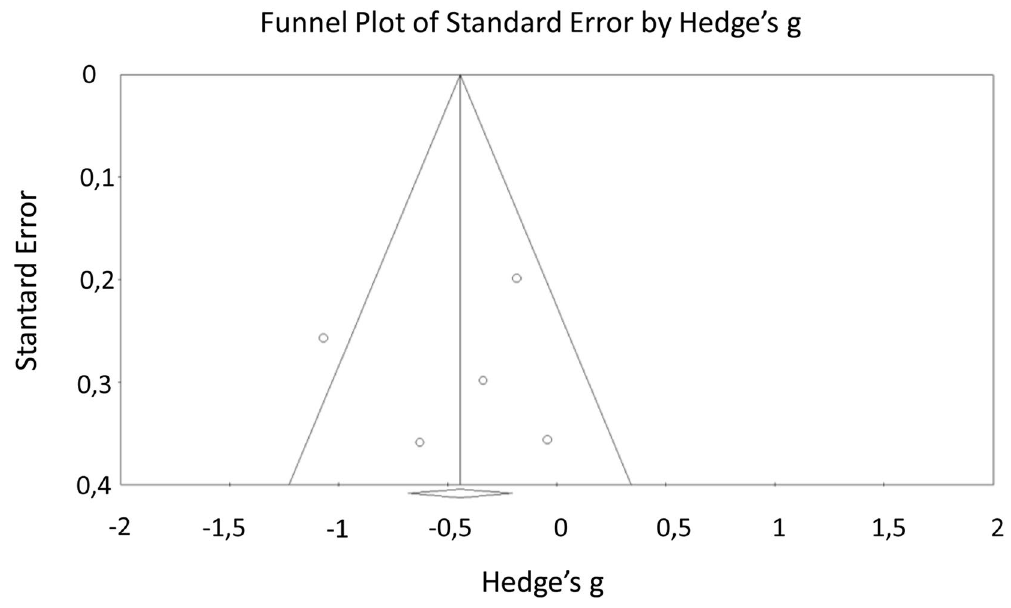
Figure 4. Funnel plot of standard error by Hedge’s g for Finger tapping test.